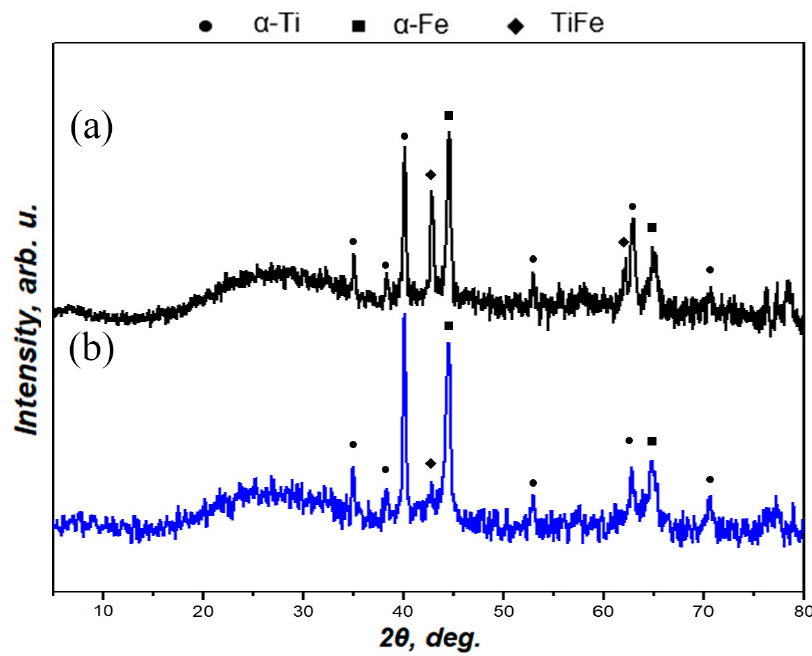
Figure 4. XRD patterns for the laser-treated ( a ) and as-prepared ( b ) Ti-Fe multilayer samples.